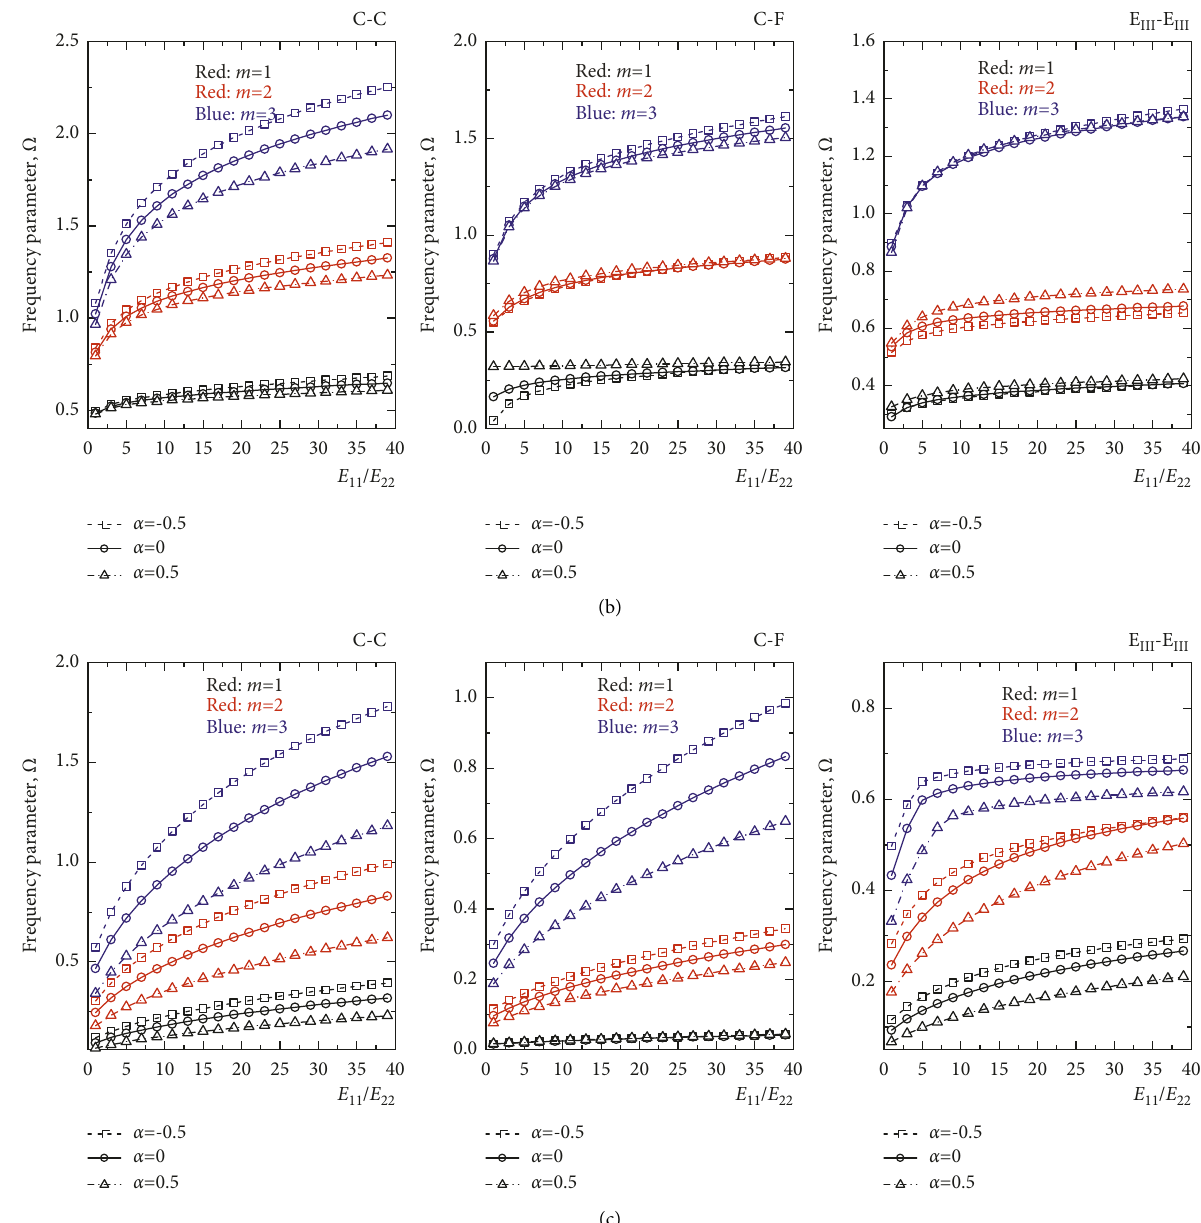
Figure 9: The frequency parameters of the laminated composite structures with different stiffness ratios and variable thickness ( n � 2): (a) conical shell, (b) cylindrical shell, and (c) annular